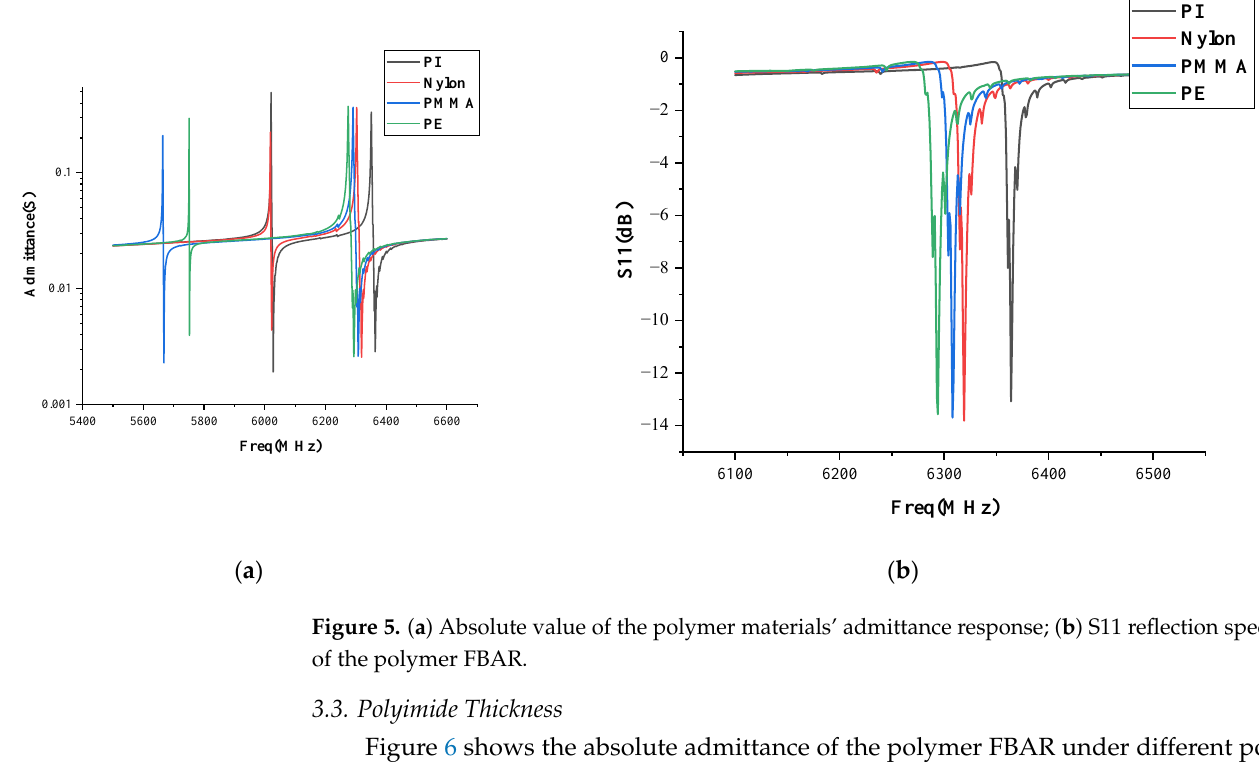
Figure 5. ( a ) Absolute value of the polymer materials ’ admittance response; ( b ) S11 reflection spectra of the polymer FBAR.